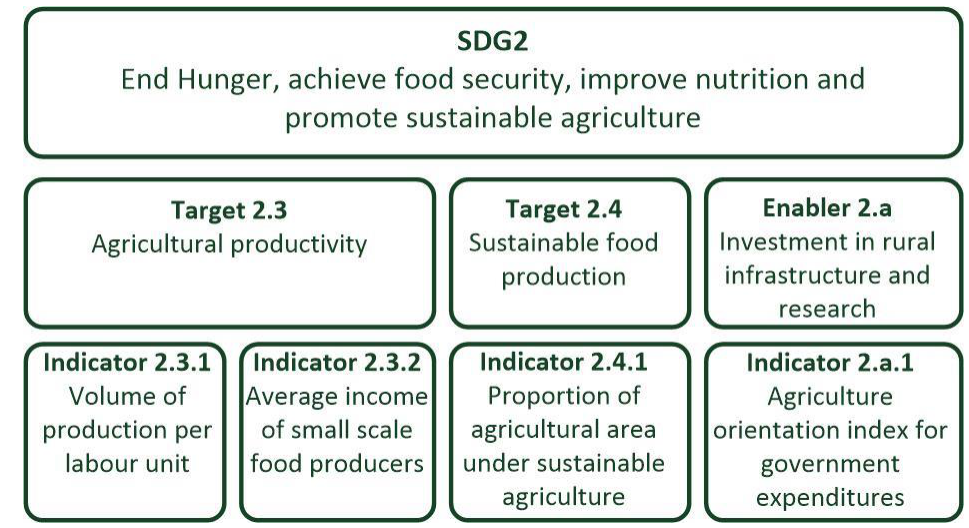
Figure 1. Sample Sustainable Development Goals (SDG) hierarchy with numbering.